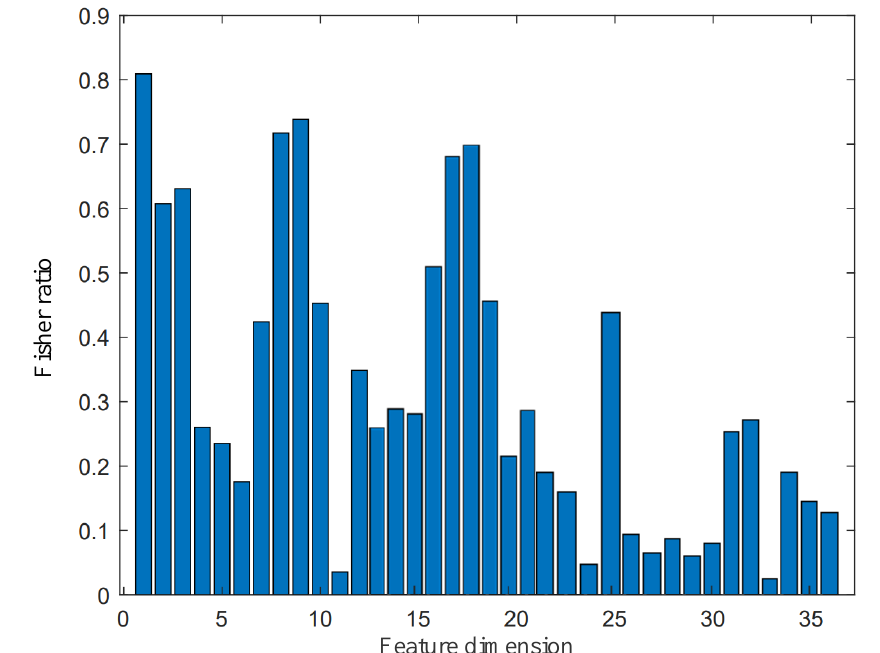
Figure 4. Fisher ratio of 36-dimensional